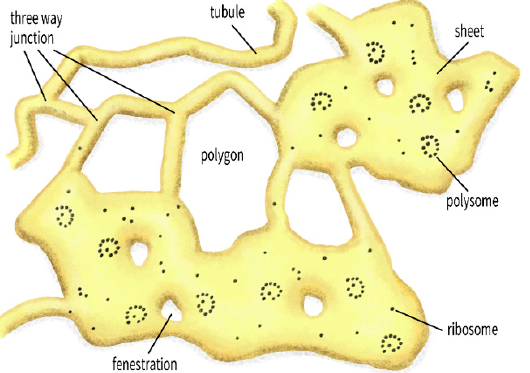
Figure 2. An illustration of ER network of sheets and tubules. Network polygons and branch points (called three way junctions), ribosomes, polysomes, and fenestrations on sheets are indi- cated.